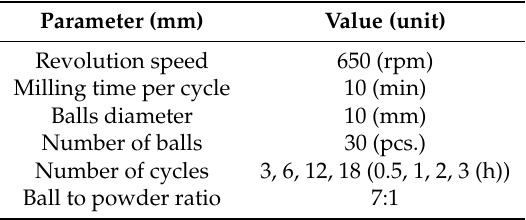
Table 1. Parameters of the milling